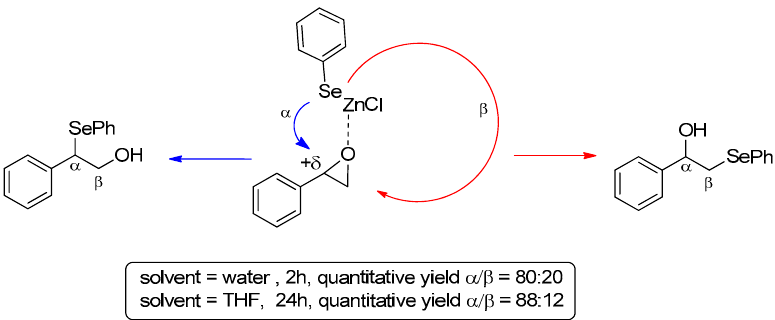
Figure 7. Regioselectivity in the ring opening of epoxide with of PhSeZnCl.